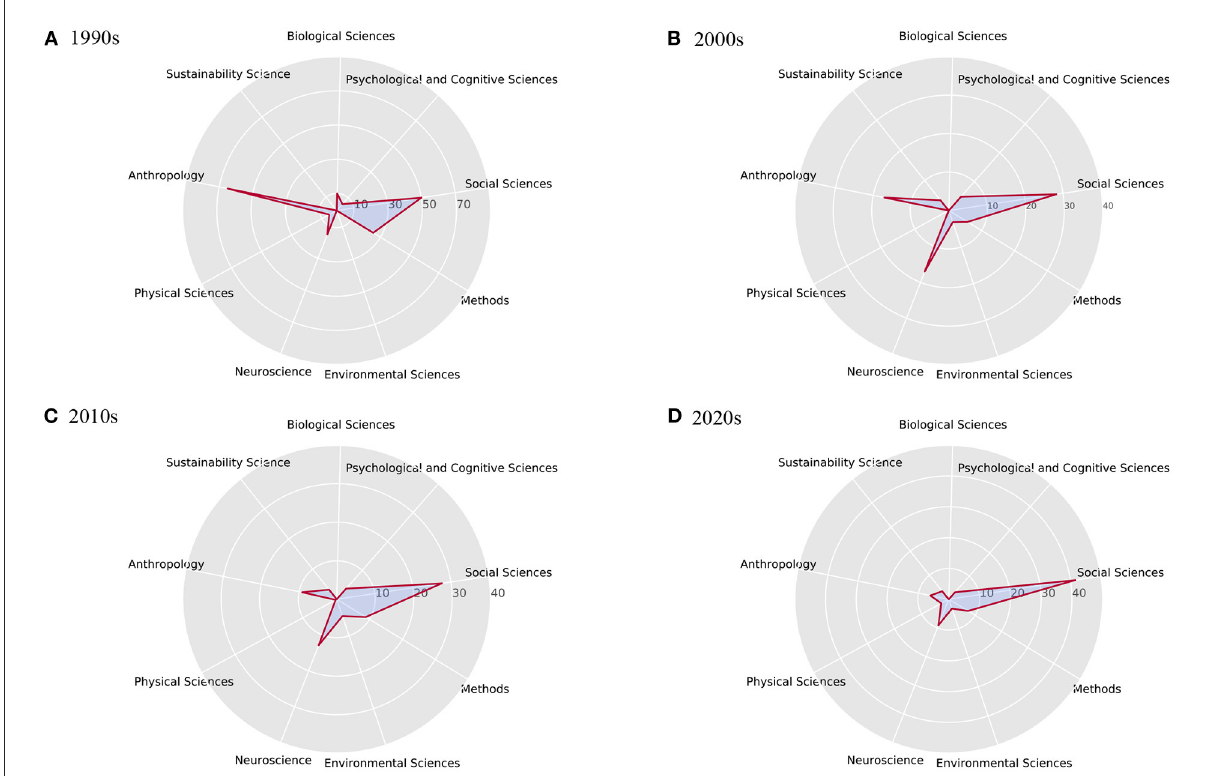
FIGURE15 Corresponding percentage of publications related to nine broad topic for four eras. It can be seen that in the 1990s (A) , many researchers focused on anthropology. In the 2000s (B) , neuroscience became a hot topic. While in the 2010s (C) and 2020s (D) , research in the field of social sciences mostly focus on social problems and scientific solving